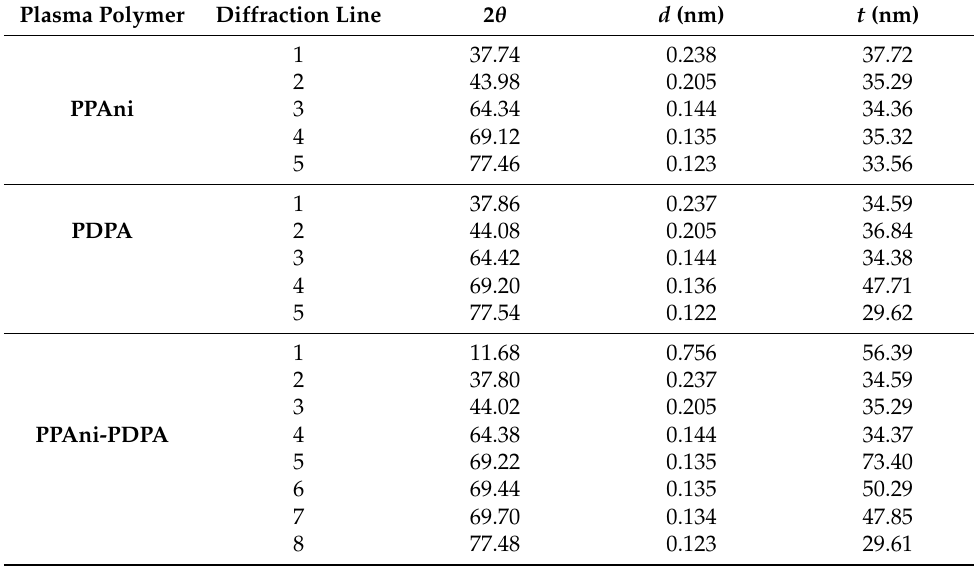
Figure 7. XRD patterns of PPAni, PDPA, and PPAni-PDPA. Table 3. Indexing of diffraction lines for PPAni, PDPA, and PPAni-PDPA. Plasma